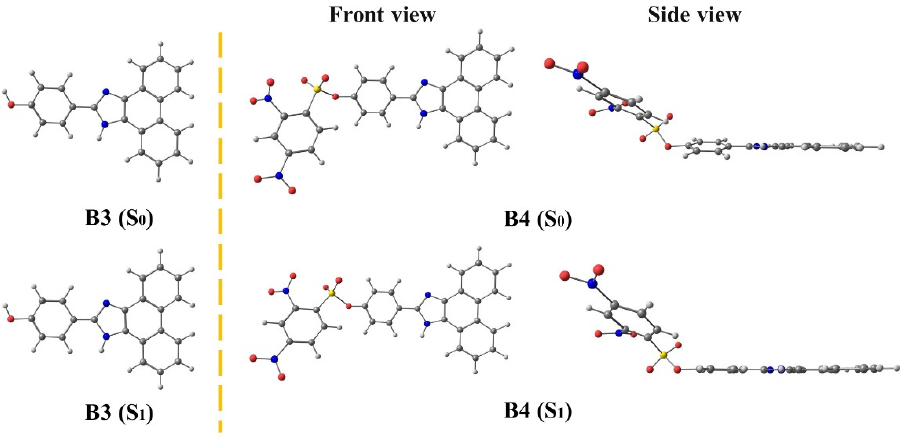
Figure 4. B3LYP − D3/TZVP/IEFPCM-optimized geometries of B3 and B4 in the S 0 and S 1 state. Table 3. B3LYP − D3/TZVP/IEFPCM levels calculated electronic excitation energies (nm), corre- sponding oscillator intensities and corresponding compositions for the B3 and B4 compounds.